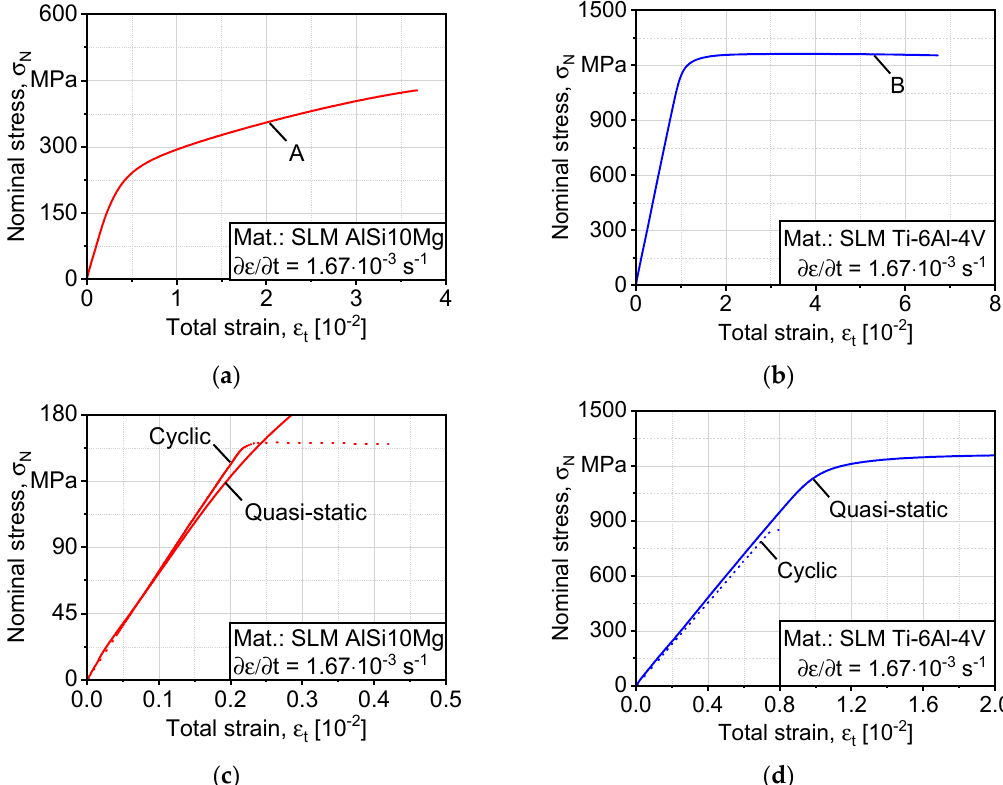
Figure 2. Quasi-static stress–strain curves used to deduce isotropic hardening parameters: ( a ) AlSi10Mg; ( b ) Ti-6Al-4V, in the applied cyclic load range; ( c , d ) comparison between cyclic hardening (AlSi10Mg) and softening (Ti-6Al-4V) in both alloys. SLM, selective laser melted.